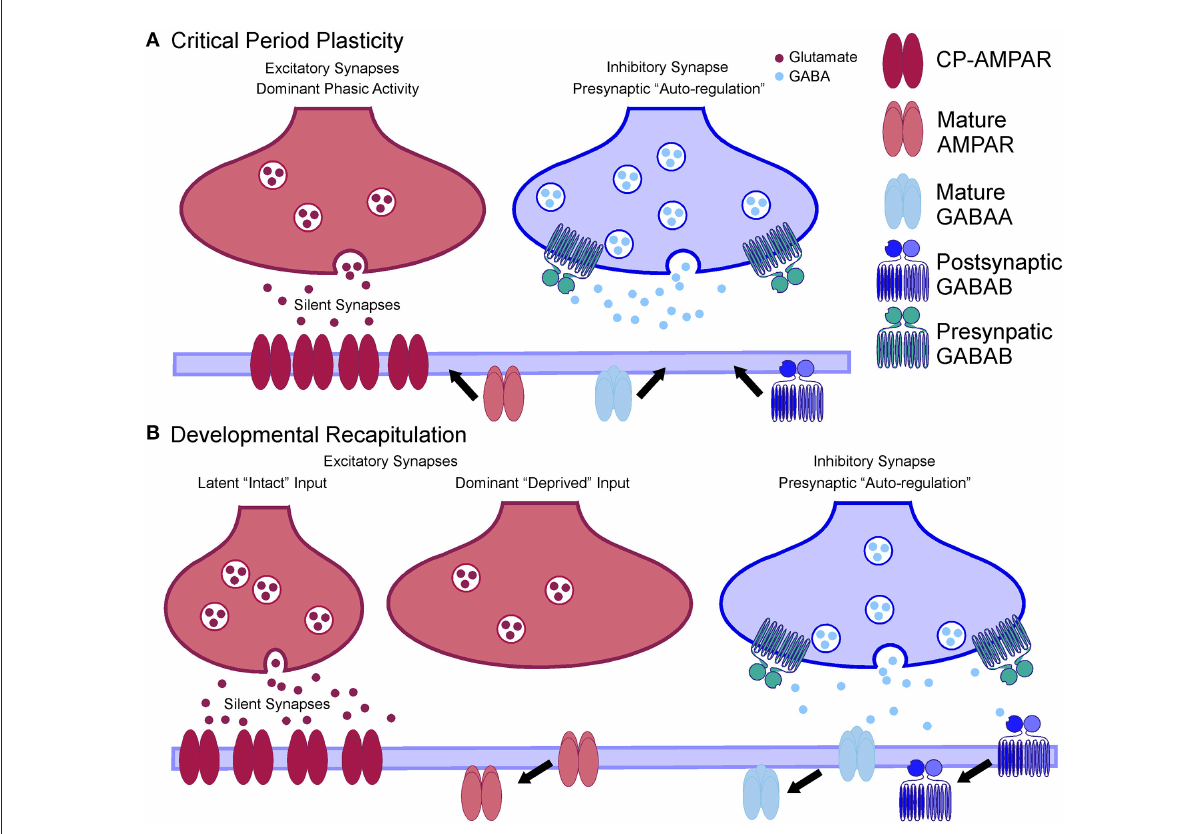
FIGURE2 Parallels between critical period plasticity at developing synapses and developmental recapitulation at adult synapses. (A) Left: Cartoon showing calcium permeable AMPAR at silent excitatory synapses being activated and recruiting mature GluR2/3 containing AMPAR to the active dominant synapse. Right: Cartoon showing presynaptic GABAB autoregulation of inhibitory synapses prior to delivery of the mature postsynaptic GABAA and GABAB receptors, which are a hallmark of the closure of critical period plasticity. (B) Left: Cartoon showing the activation of calcium-permeable AMPAR at latent silent synapses after sensory deprivation of the normally dominant inputs. GluR2/3 containing AMPAR are removed from the deprived synapses until CP-AMPAR mediated processes can establish new “dominant” inputs. Right: